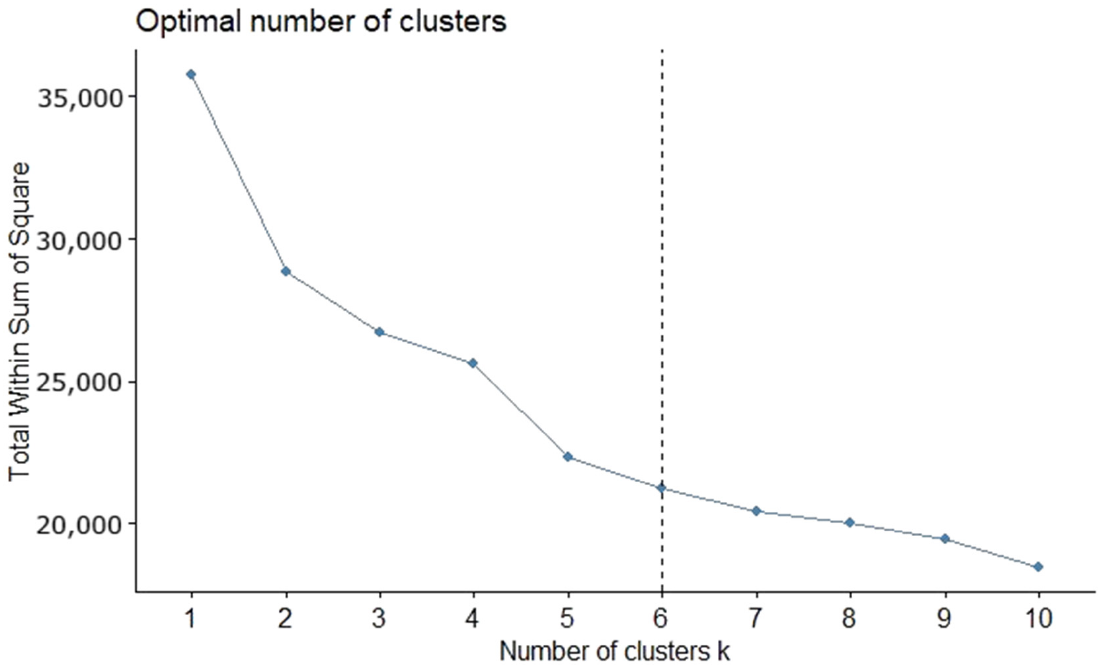
Figure 2. Process of obtaining the optimal number of clusters from the Elbow method. Source: authors’ own elaboration.